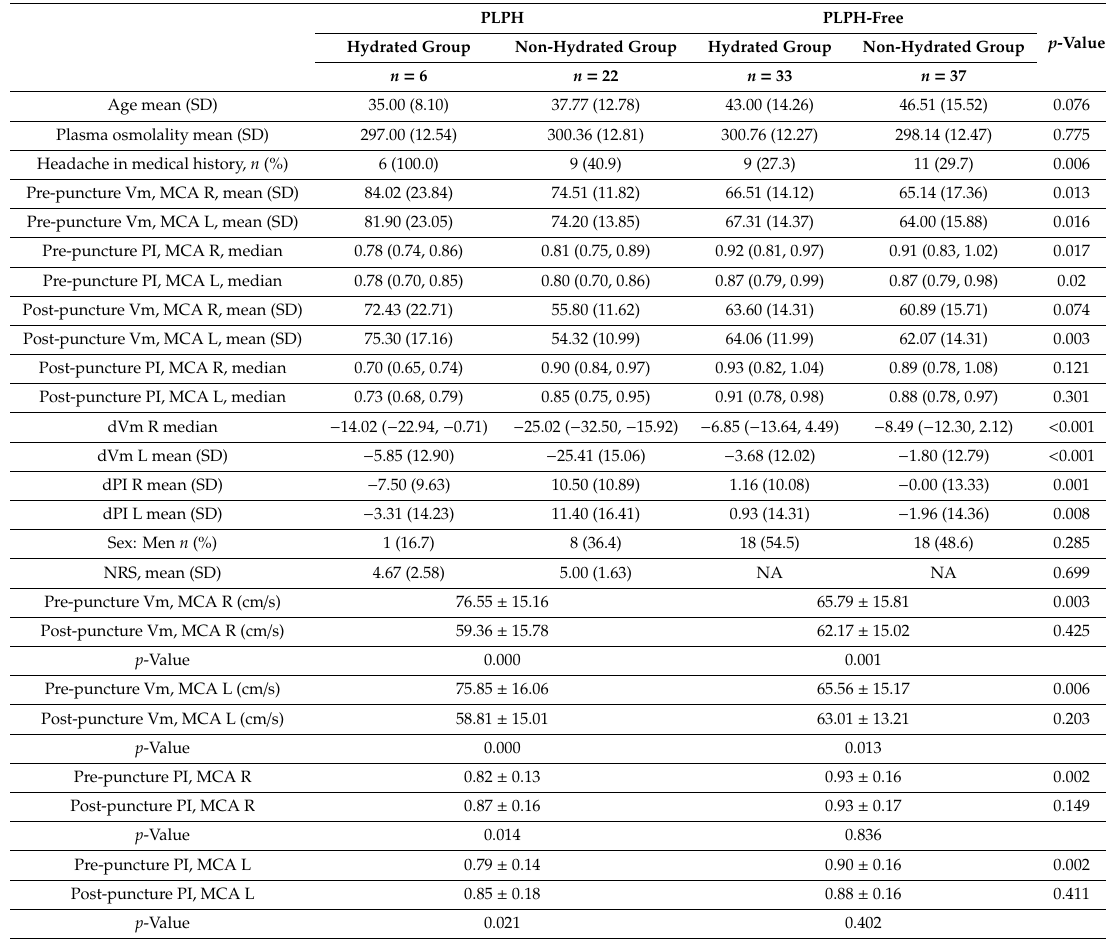
Table 2. Characteristics and transcranial Doppler (TCD) parameters before and after puncture in groups of patients who developed post-lumbar puncture headache (PLPH) and in PLPH-free individuals, depending on the